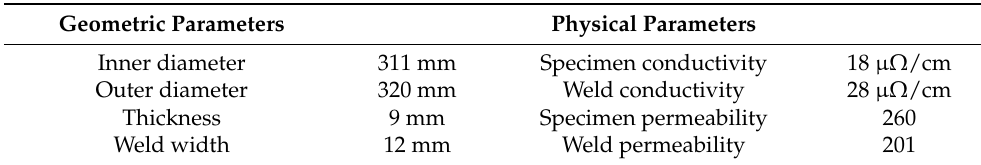
Table 1. Geometric and physical parameters of the test pipe.